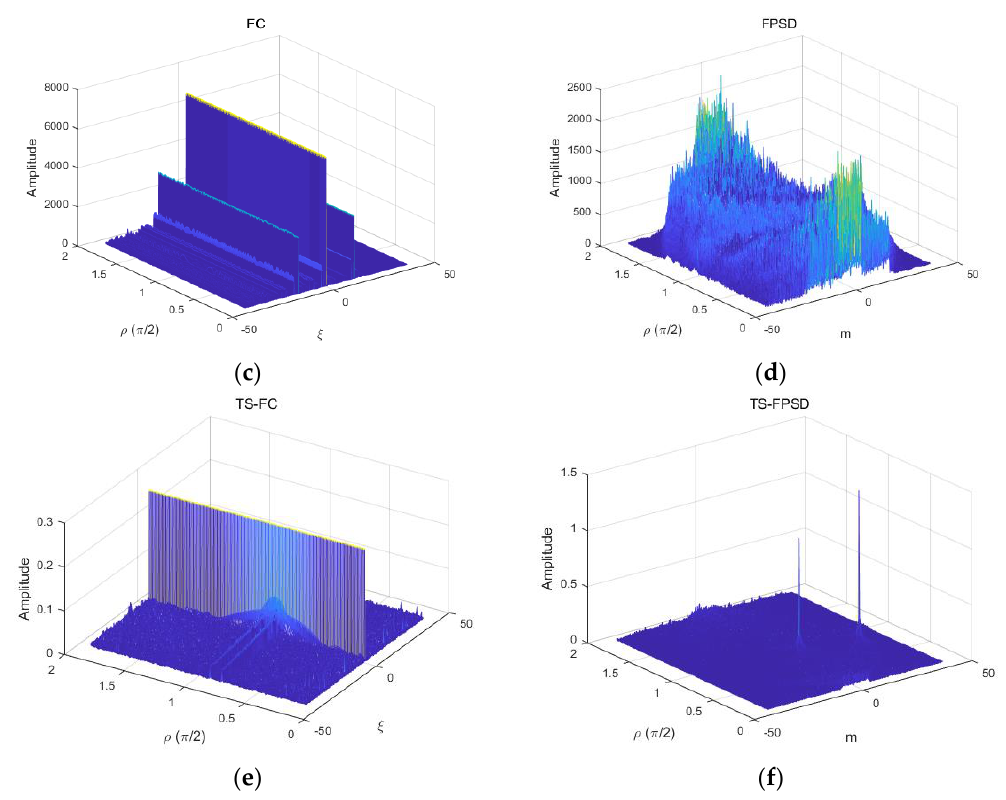
( f ) Figure 1. Time–frequency distribution of the fractional power spectrum density (FPSD) and tuneable Sigmoid (TS)-FPSD. ( a ) The fractional correlation (FC) of two LFM signals; ( b ) the FPSD of two LFM signals; ( c ) the FC of two LFM signals with S α S noise; ( d ) the FPSD of two LFM signals with S α S noise; ( e ) the TS-FC of two LFM signals with S α S noise; ( f ) the TS-FPSD of two LFM signals with S α S noise.